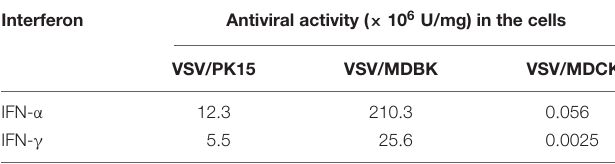
TABLE 1 | Antiviral activities of IFN- α and IFN- γ in different cells. Interferon Antiviral activity ( × 10 6 U/mg) in the cells VSV/PK15